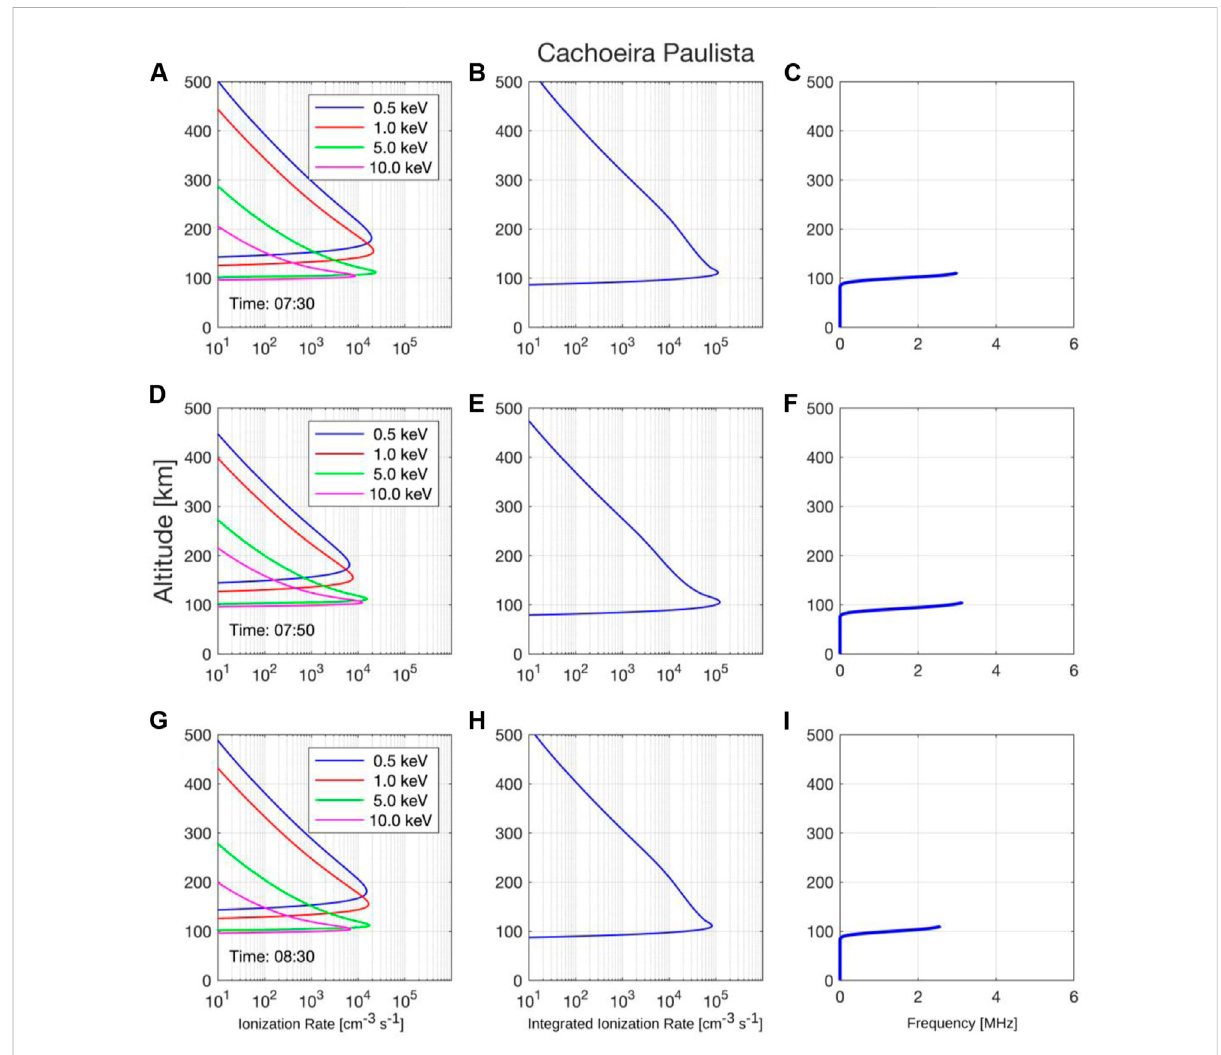
FIGURE 12 Ionization rate altitude pro fi les panels (A,D,G) , ionization rate altitude integrated panels (B,E,H) and frequency range altitude panels (C,F,I) considering the second conjunction for Cachoeira Paulista station. The total incident energy of electrons is presented in Figure 10 (bottom panel). The ionization rate is obtained from empirical model (Fang et al., 2010) considering the total incident energy of electrons presented in Figure 10 (bottom panel) and the height scale presented in Figure 15 (bottom